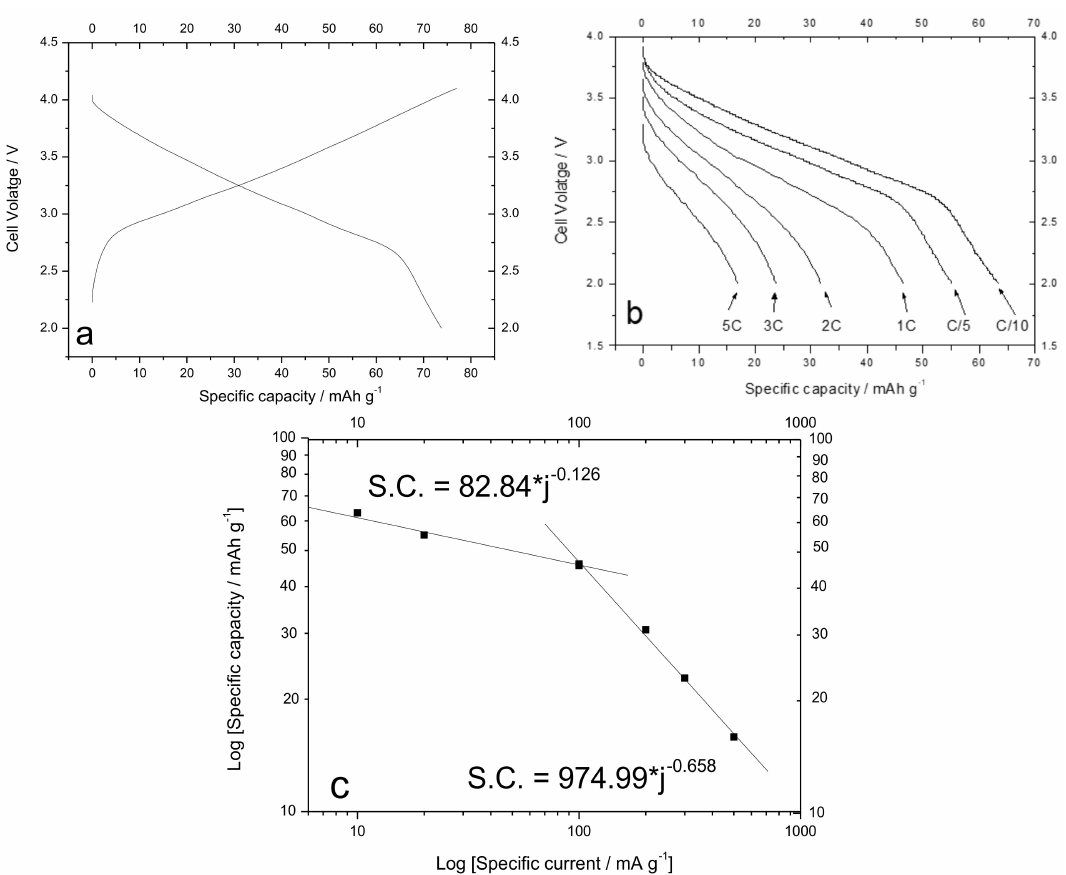
Figure 11. ( a ) Voltage profiles in charge and discharge for the Na 1.0 Li 0.2 Ni 0.25 Mn 0.75 O δ electrode recorded C/10. ( b ) Discharge voltage profiles for the electrode at various rates as a function of the specific capacity. The discharge rates are reported in the figure. ( c ) Log–log plot of the specific capacity as a function of the specific current. The equation inside the graph shows the result of the linear